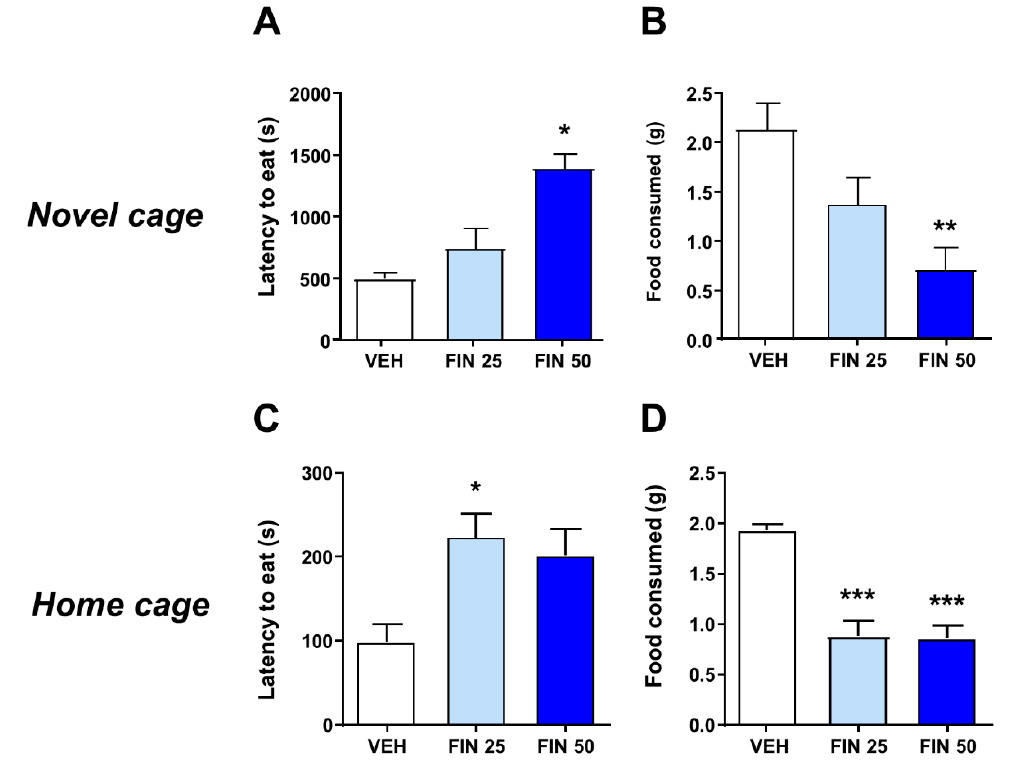
Figure 2. Finasteride (FIN) reduced appetitive motivation in the novelty-induced hypophagia test. In a novel cage, FIN-treated rats displayed an increased latency to consume palatable food ( A ) and reduced amounts of food consumed ( B ); n = 10–11 / group. Similar outcomes, however, were also observed in home cages; n = 9 / group ( C,D ). * p < 0.05, ** p < 0.01, *** p < 0.001 in comparison with rats treated with vehicle (VEH). Doses of FIN are indicated in mg / kg